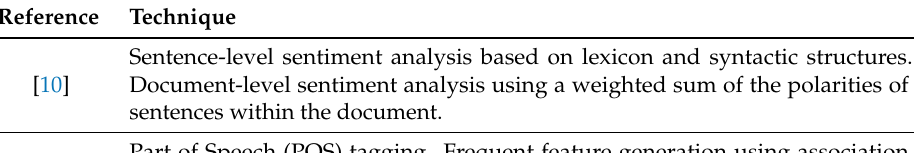
Table 2. Techniques of detection